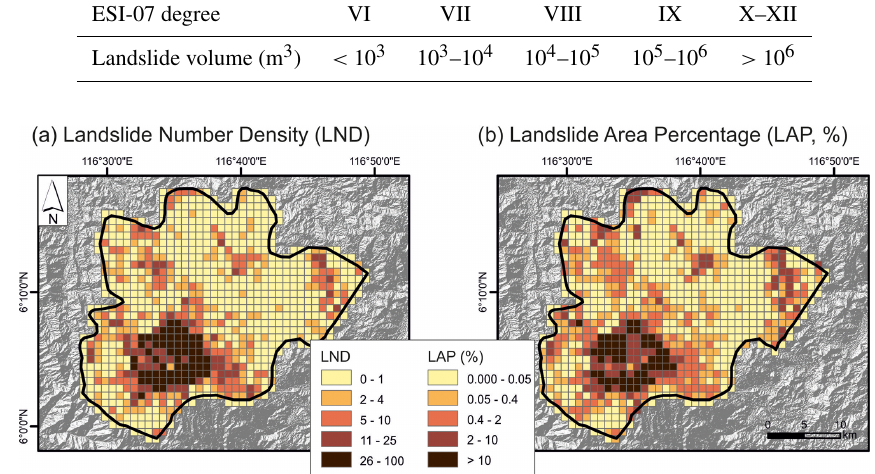
Figure 4. Grid maps of landslide number density (LND, a ) and landslide area percentage (LAP, b ). Color map follows Crameri et al.